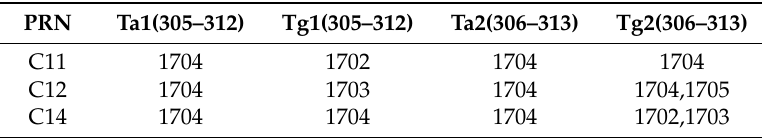
Table 2. Time shift of MEO for DOY 305, 312 and 306, 313 (unit: s).